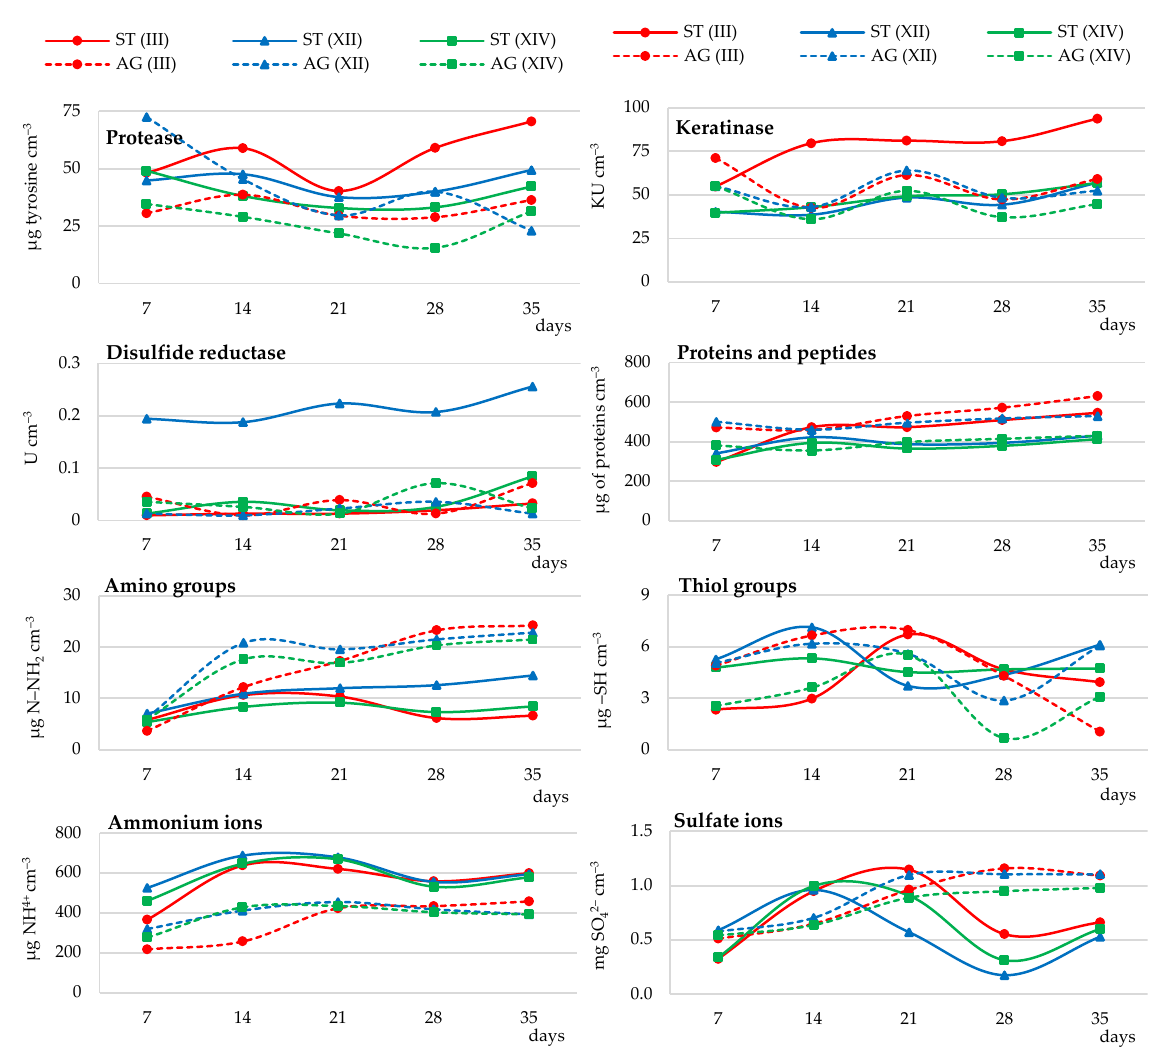
Figure 5. Dynamics of changes in enzymatic activity and released organic and mineral keratinolysis products in different culture methods (agitated—AG and stationary— ST) analyzed for three Trichophyton ajelloi strains III, XII, and XIV.